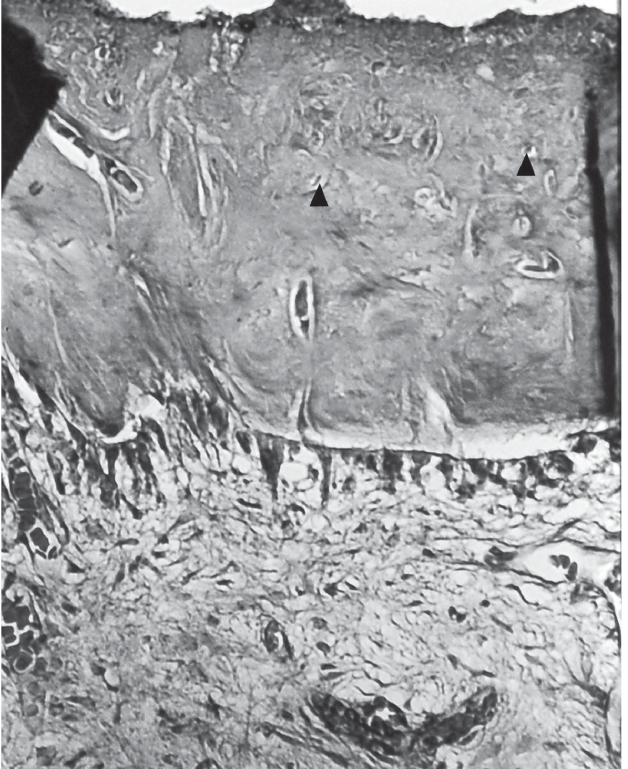
Fig. 4 - (group II; 30th day) - Included cells in the midst of hard barrier tissue underlined by odontoblast-like cells (arrowheads). Absence of inflammatory characteristics in the subjacent pulp tissue. Masson Trichrome stain, original magnification 125X.